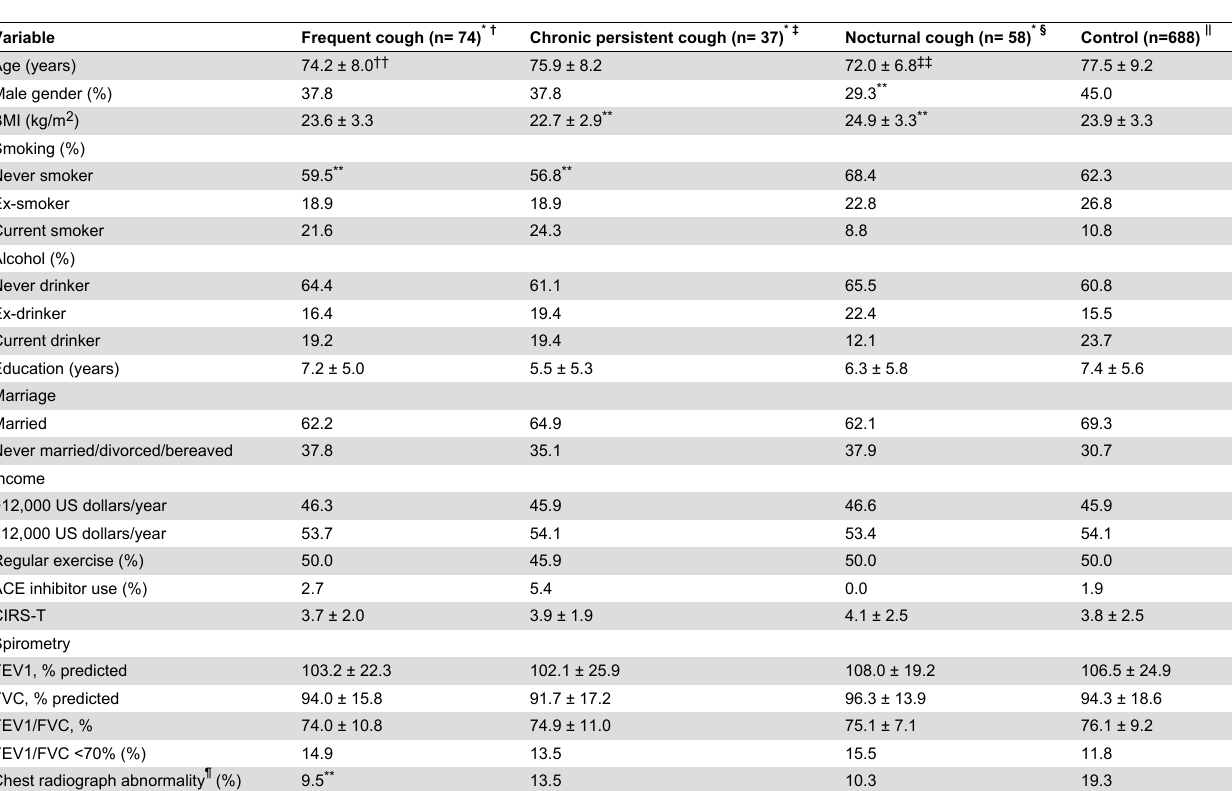
Table 1. Baseline characteristics of the study